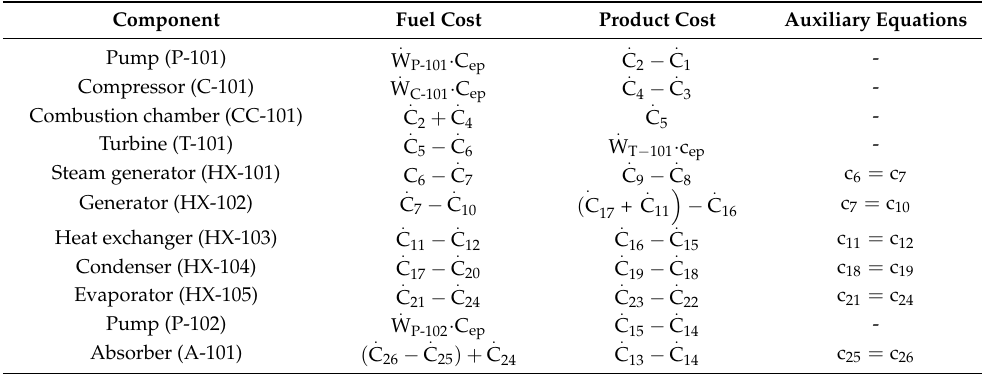
Table 6. Cost balance equations and auxiliary equations for exergy costs of the